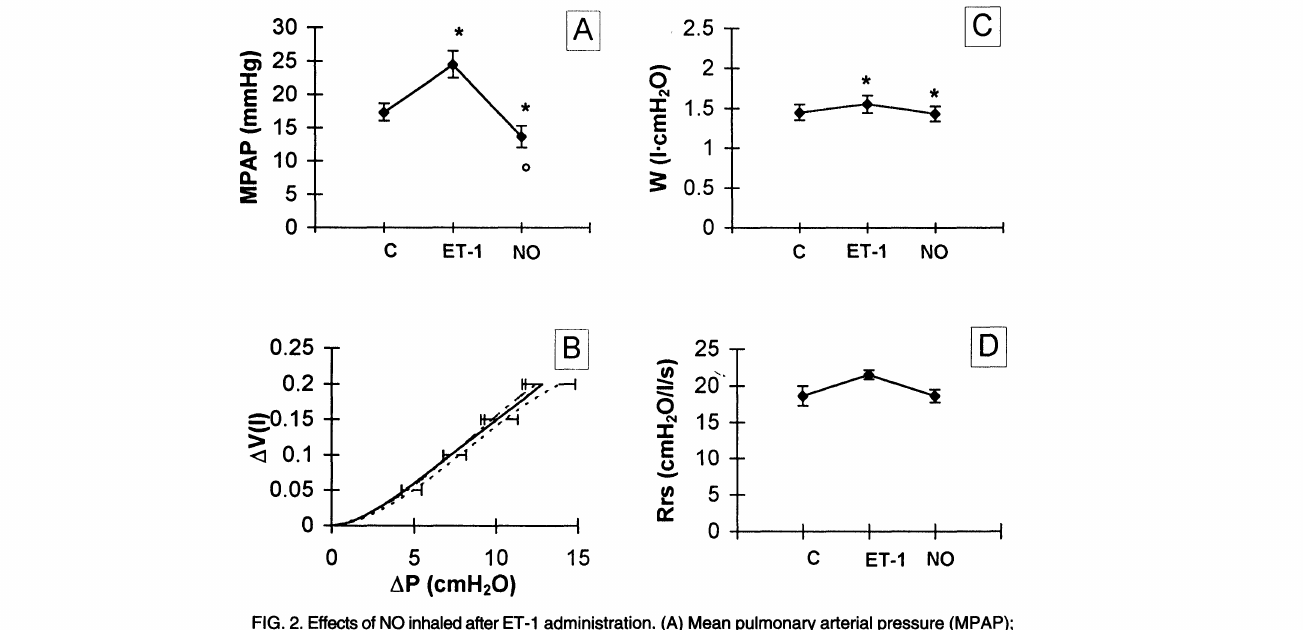
FIG. 2. Effects of NO inhaled after ET-1 administration. (A) Mean pulmonary arterial pressure (MPAP); (B) volume-pressure (zV/zP) relationships of respiratory system obtained in control conditions (--), after ET-1 administration and after NO inhalation